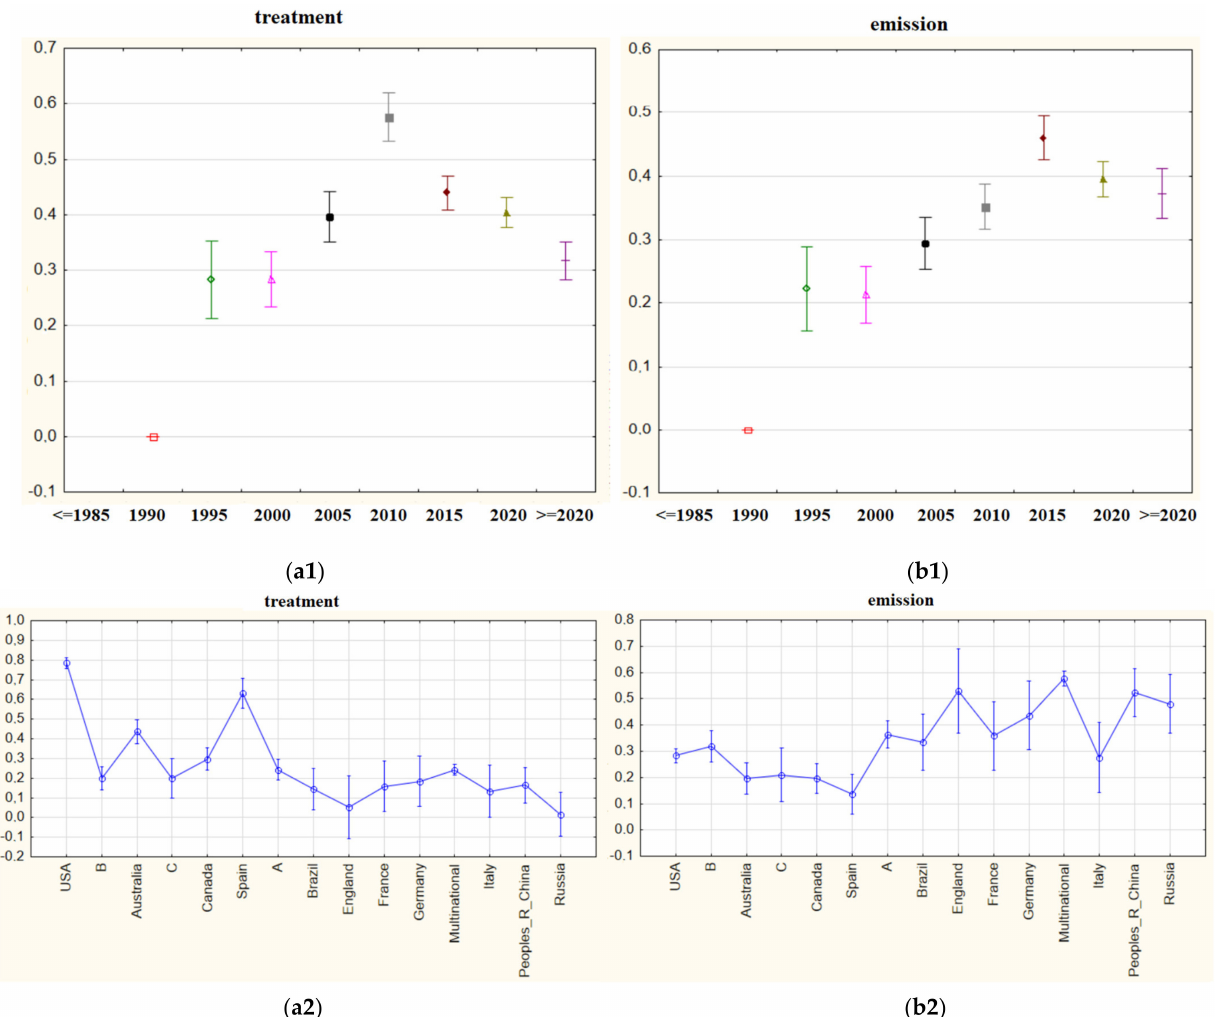
Figure 9. ( a1 ) mean importance weights of the indexed word “treatment” for five-year periods; ( b1 ) mean importance weights of the indexed word “emission” for five-year periods; ( a2 ) mean importance weights of the indexed word “treatment” via countries; ( b2 ) mean importance weights of the indexed word “emission” via